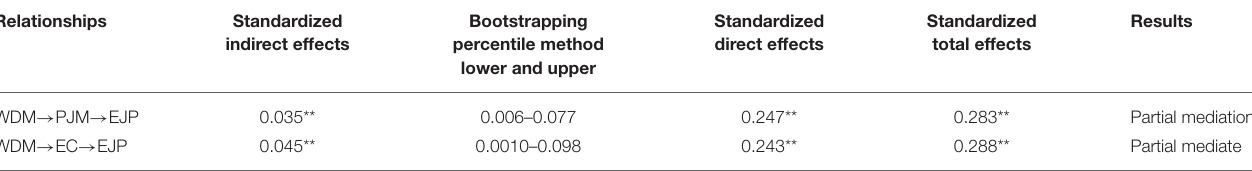
TABLE 3 | Mediation analysis (Bootstrapping).